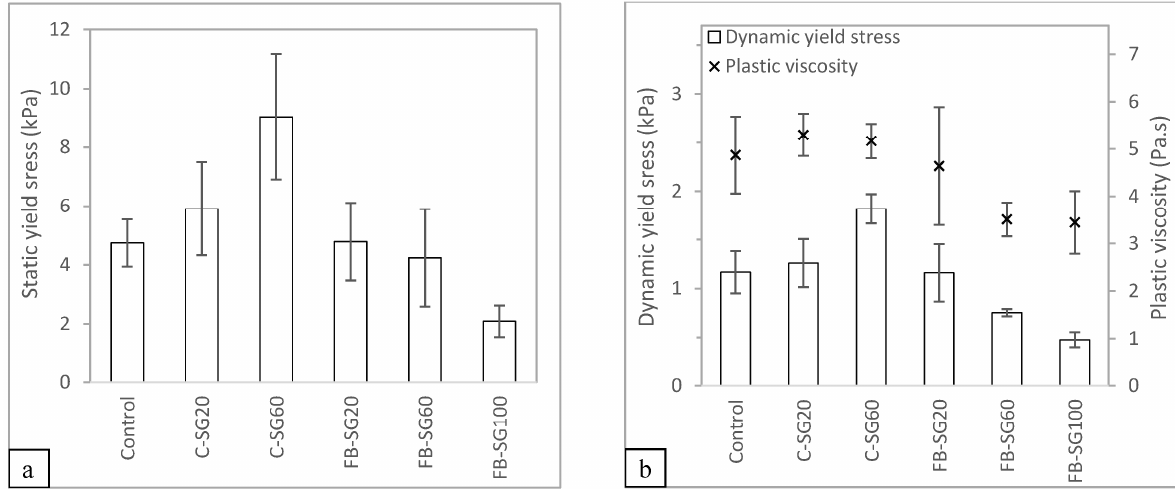
Figure 6. ( a ) Static yield stress results and ( b ) dynamic yield stress results of mixtures prepared with the speci fi c gravity method.